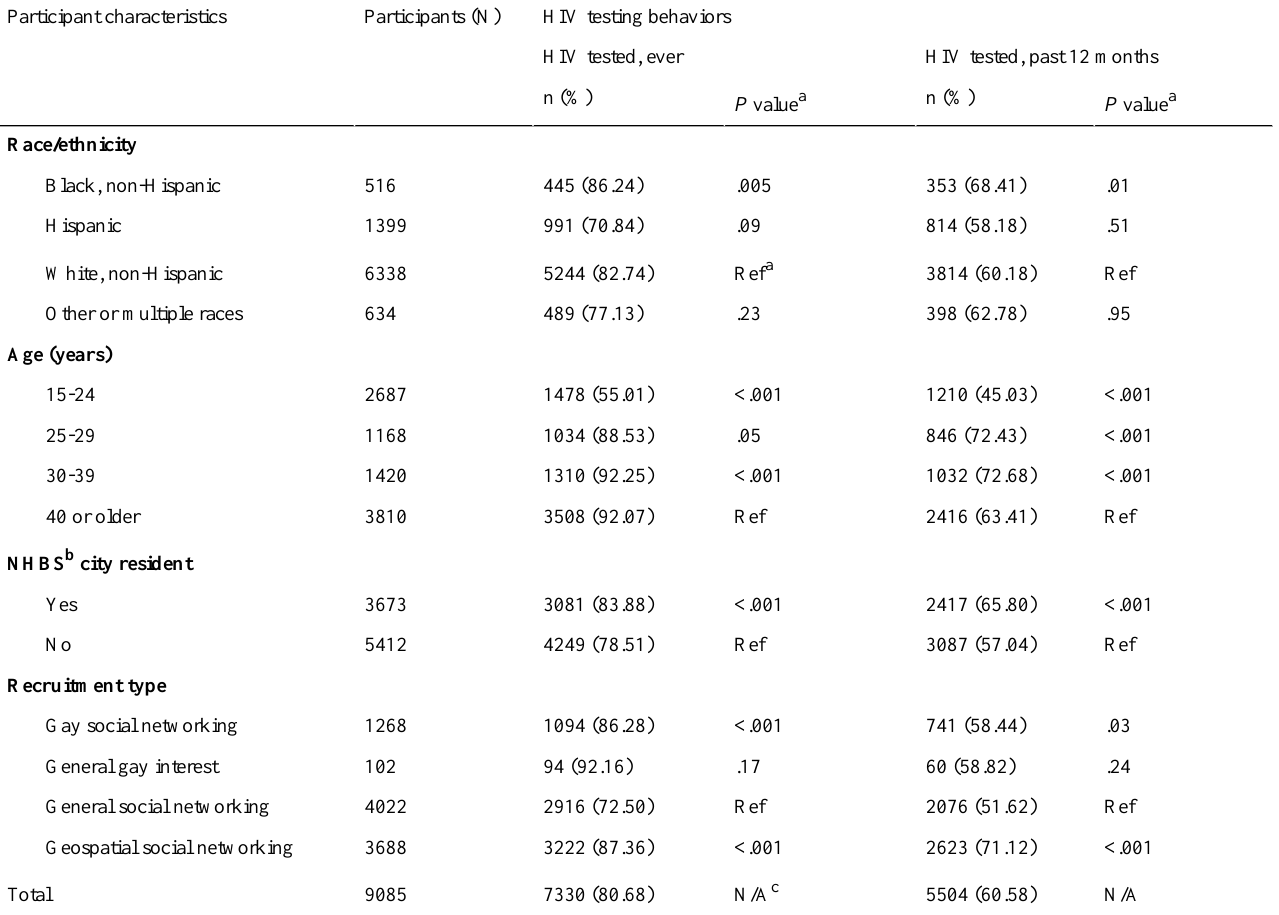
Table 5. HIV testing behaviors of HIV-negative or unknown-status men who have sex with men in the American Men’s Internet Survey, United States,